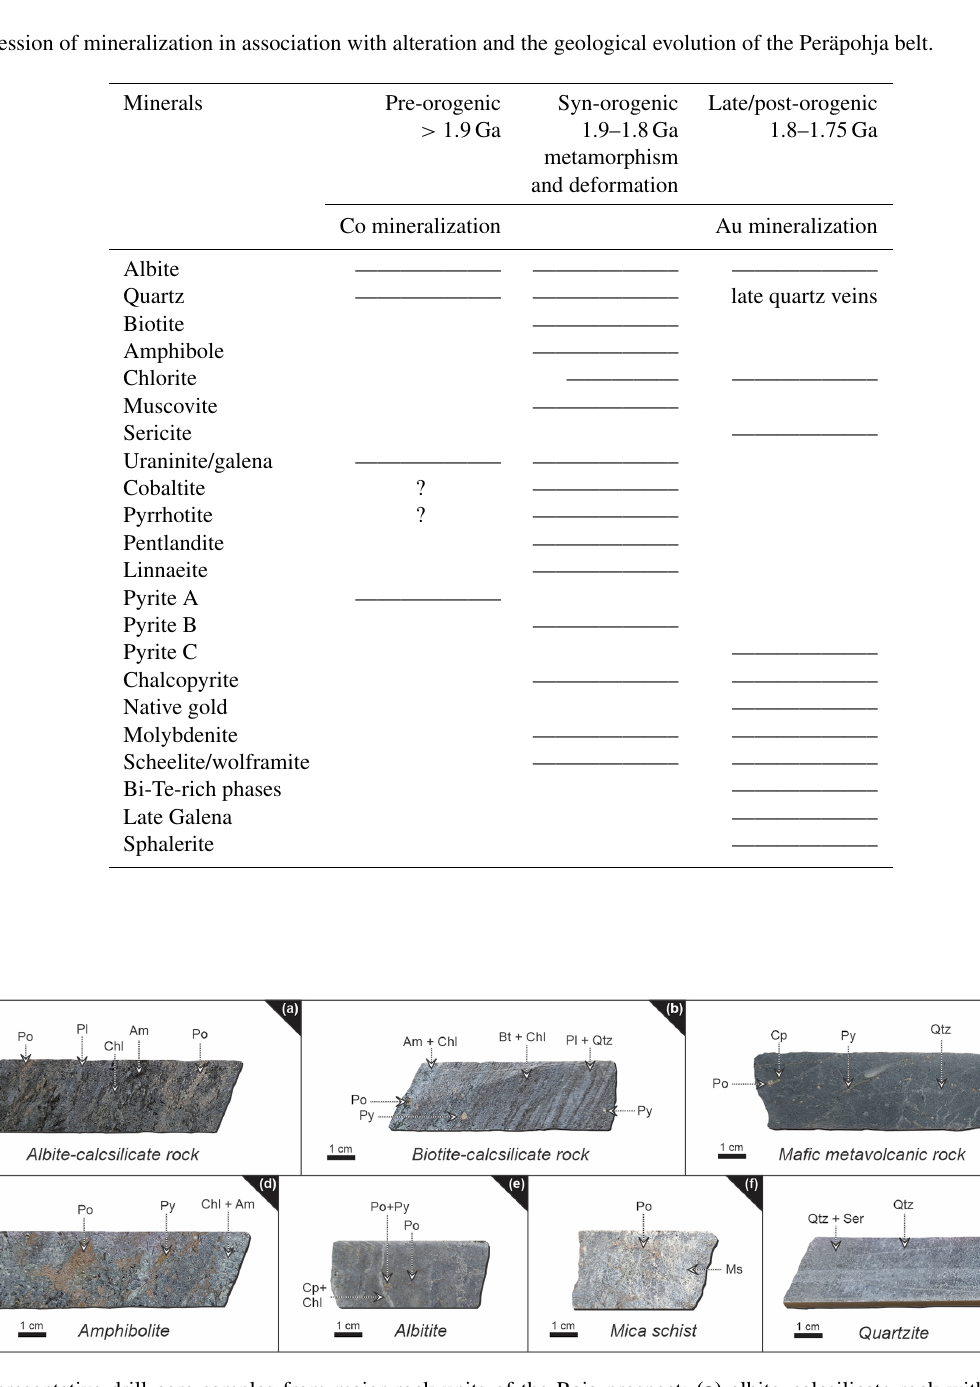
Figure 3. Representative drill core samples from major rock units of the Raja prospect: (a) albite–calcsilicate rock with radial-growing crystals of amphibole and chlorite, as well as disseminated pyrrhotite. (b) Biotite–calcsilicate-rich rock with alternating mafic and felsic layers, significant foliation and rotated pyrite porphyroclasts. (c) Fine-grained mafic metavolcanic rock (hyaloclastite) with fracture-filling, as well as disseminated pyrrhotite and pyrite. (d) Mineralized amphibolite with euhedral crystals of tourmaline. (e) Fine-grained albitite with fracture-filling chlorite and chalcopyrite, as well as disseminated pyrrhotite and pyrite. (f) Muscovite-rich mica schist with disseminated pyrrhotite. (g) Fine-grained quartzite with sericitic alteration. Pl – plagioclase, Qtz – quartz, Bt – biotite, Am – amphibole, Chl –